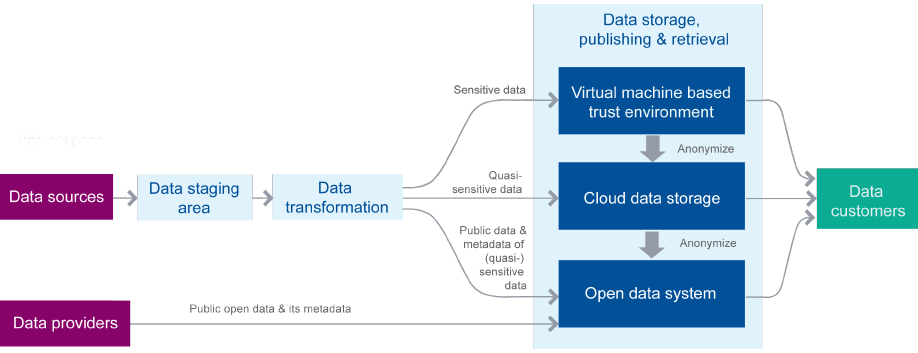
Figure 3. Architecture of data